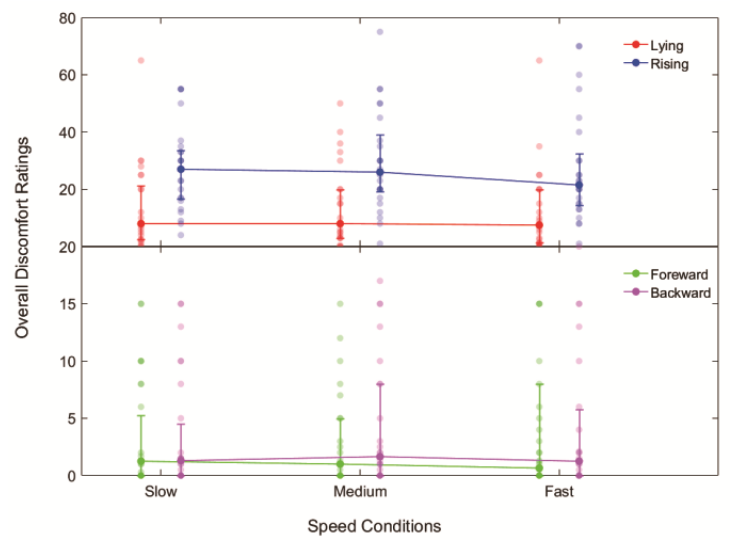
Figure 3. Individuals, medians, and interquartile ranges (IQRs) of overall discomfort ratings for 24 subjects.